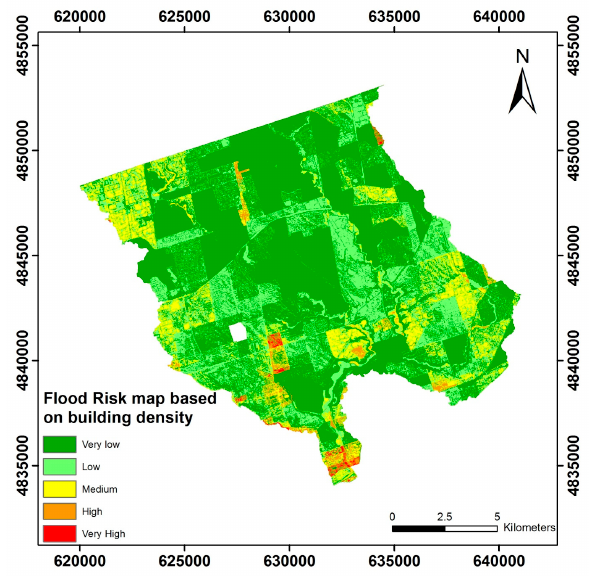
Figure 7. Flood risk map based on total flood hazard and total social vulnerability. Note: In the upper region of the map, there are three distinct (green) polygon regions characterized with very low risk due to lack of data.